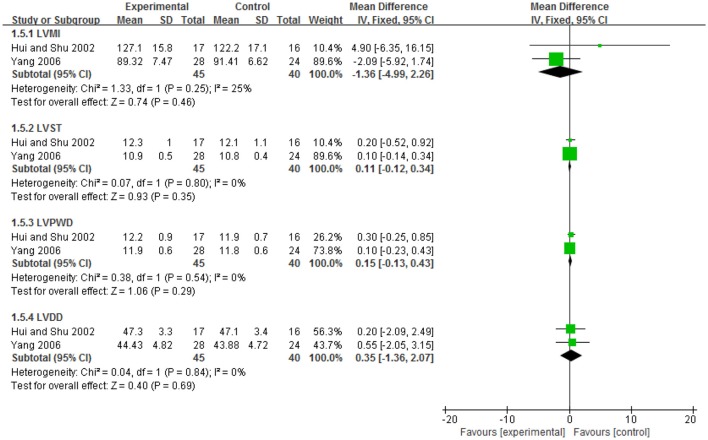
The forest plot of comparison of two groups for the outcome of left ventricular mass.